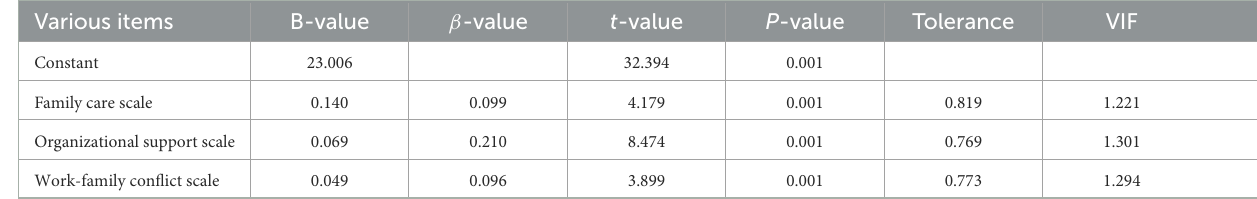
TABLE 7 Multiple stepwise regression results of nurses’ family caring, perception of organizational support, and work-family conflict on secondary trauma ( n = 2,014). Various